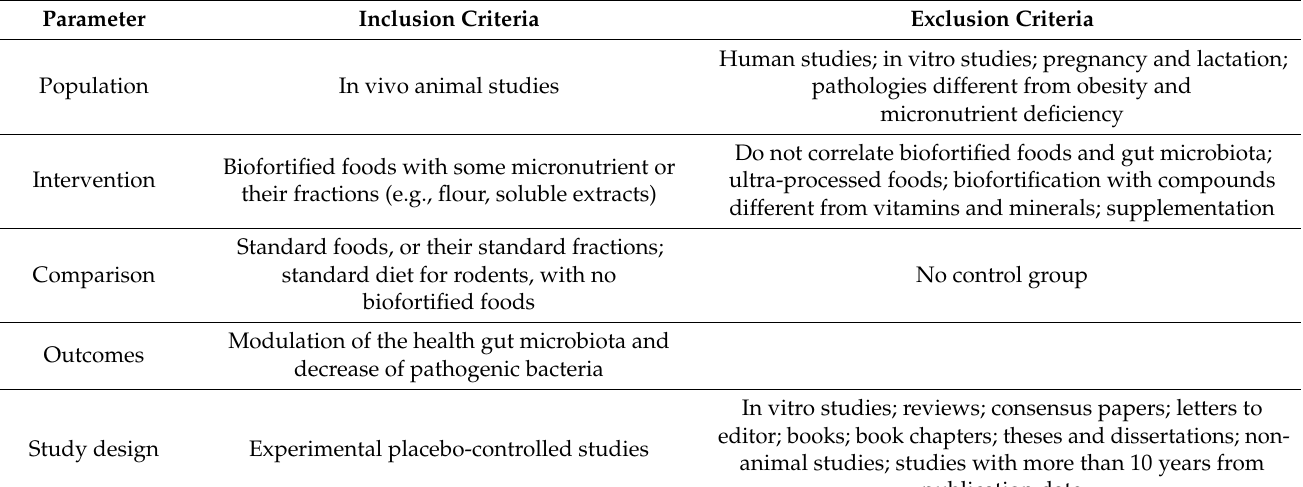
Table 1. Participants, interventions, comparisons, outcomes, and study design (PICOS) criteria for inclusion and exclusion of